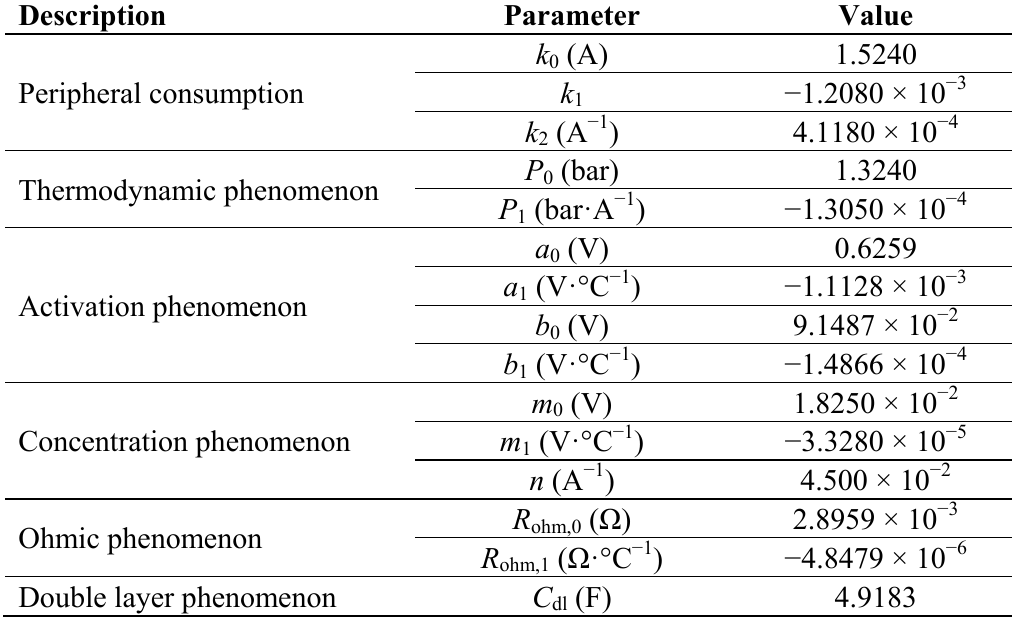
Table 1. Parameters for the electrical